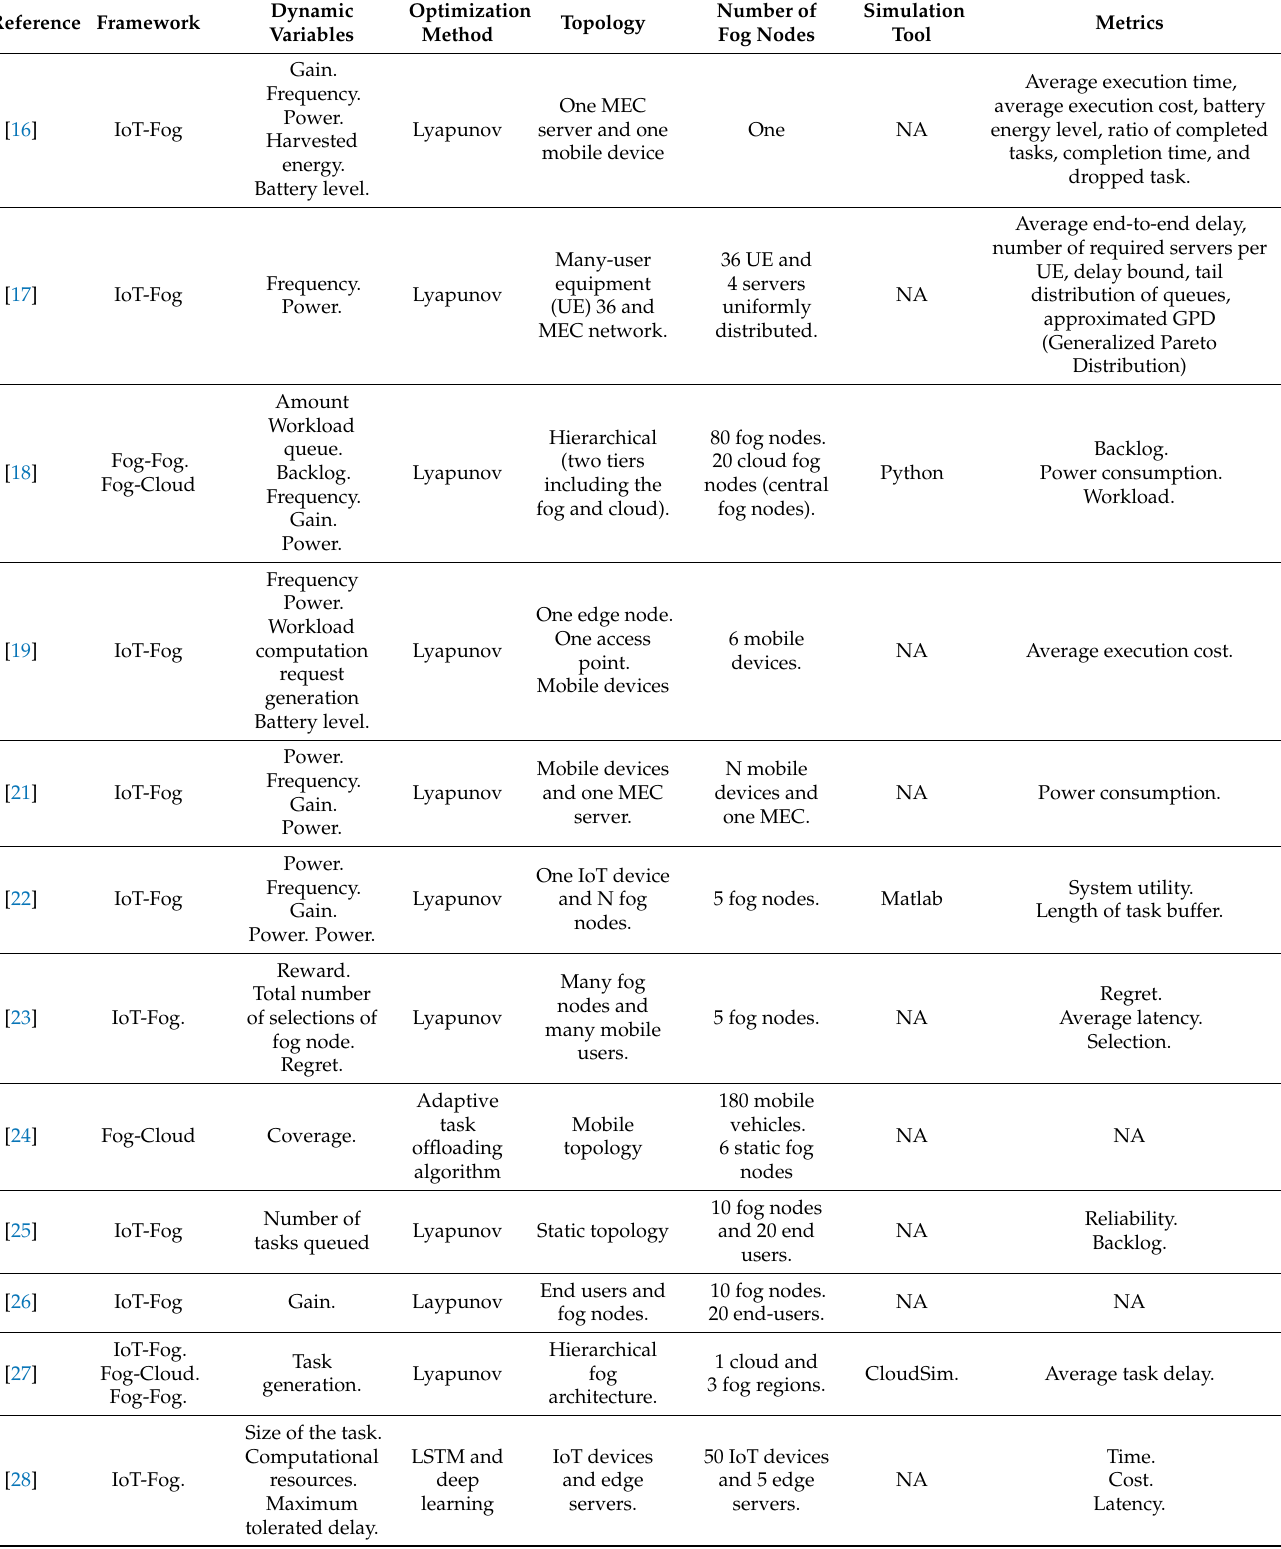
Table 1. Related works